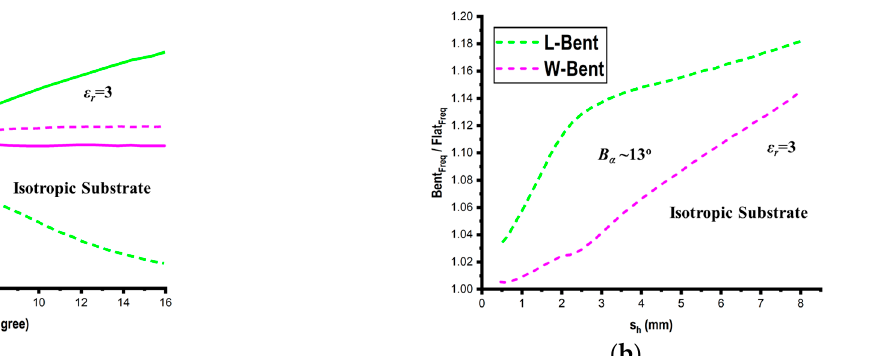
Figure 12. Bending e ff ect on an anisotropic substrate with respect to the substrate height ( s h ).